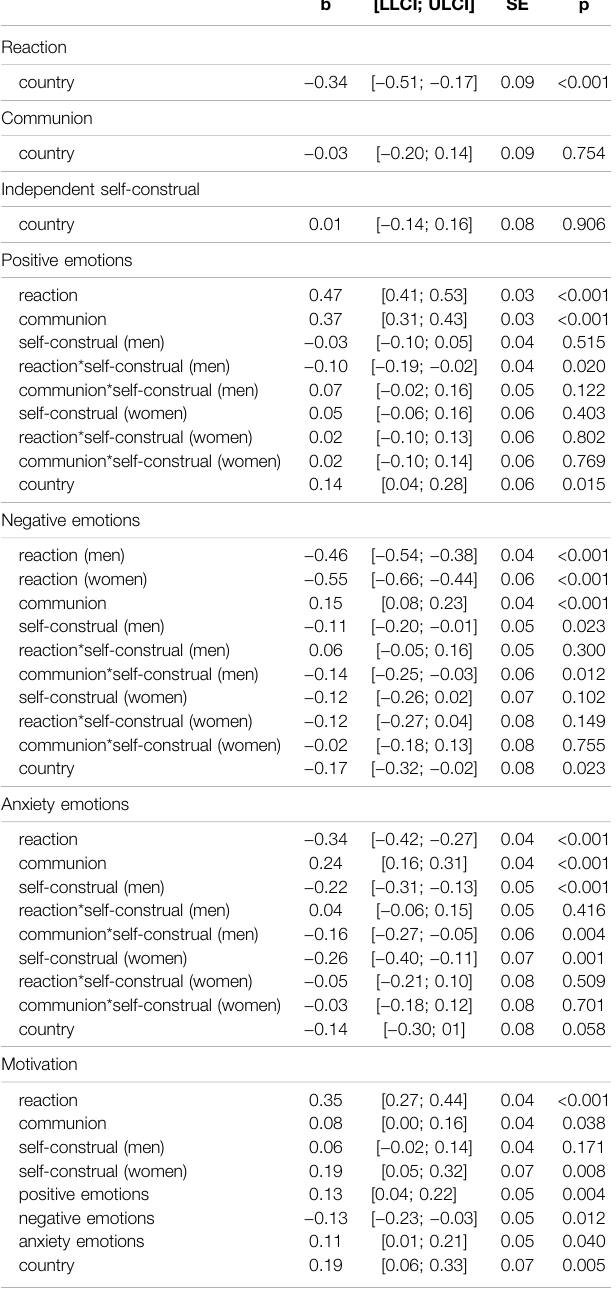
TABLE 6 | Results of path model with moderation by independent